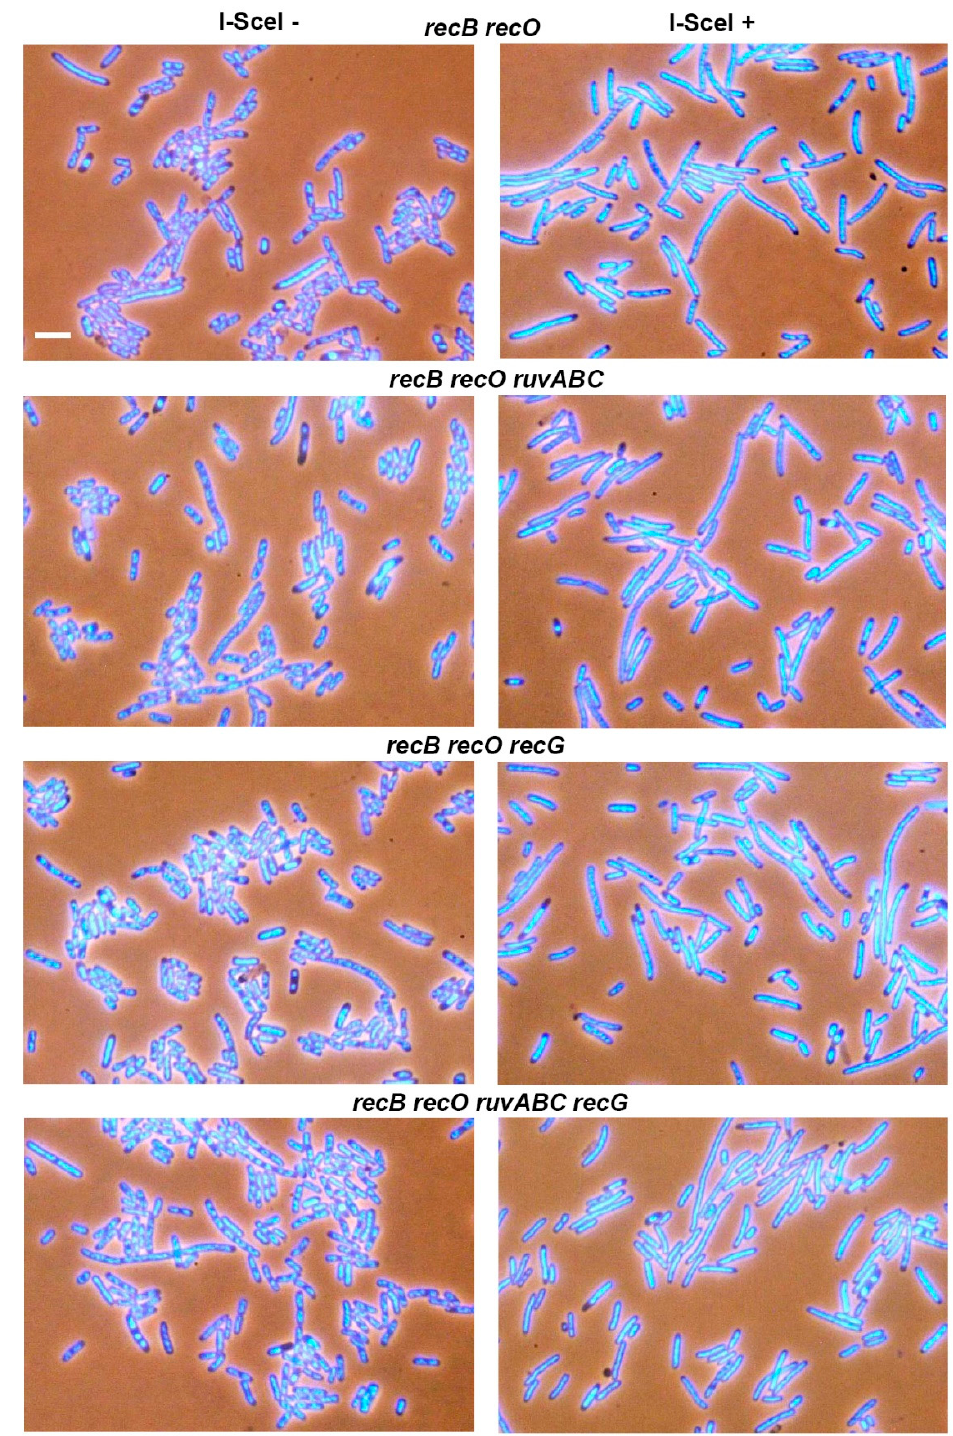
Figure 4. Effects of recB recO mutations on I- Sce I-induced cytological defects in wild-type, ruvABC and/or recG backgrounds. Bar, 5 μ m.